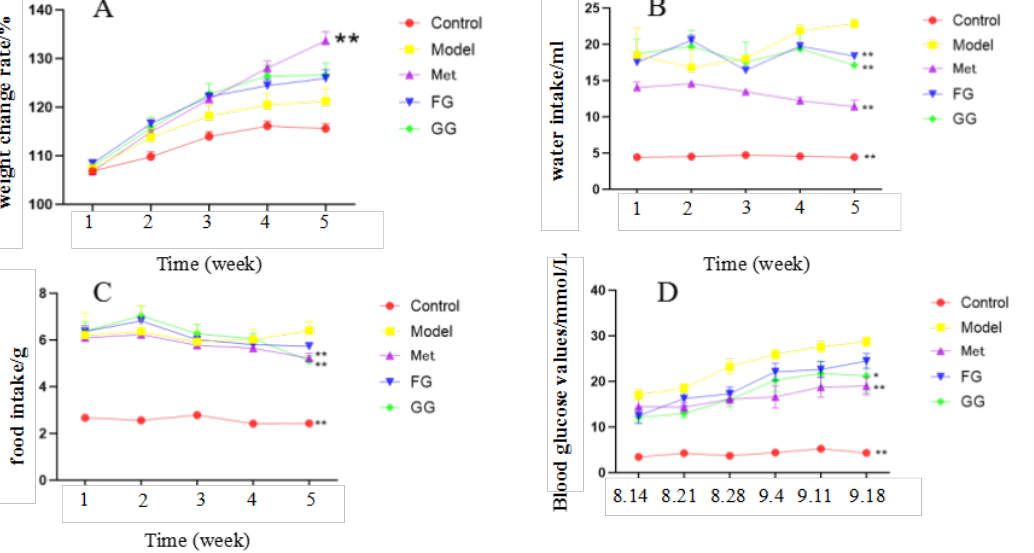
Figure 1. ( A ) Effect of Pueraria polysaccharide on body weight of db/db mice ( n = 10; ** p < 0.01 compared with the model group). ( B ) Effect of Pueraria polysaccharide on the water intake of db/db mice ( n = 10; ** p < 0.01 compared with the model group). ( C ) Effect of Pueraria polysaccharide on food intake of db/db mice ( n = 10; ** p < 0.01 compared with the model group). ( D ) Effect of Pueraria polysaccharide on fasting blood glucose in db/db mice ( n = 10; * p < 0.05; ** p < 0.01 compared with the model group).